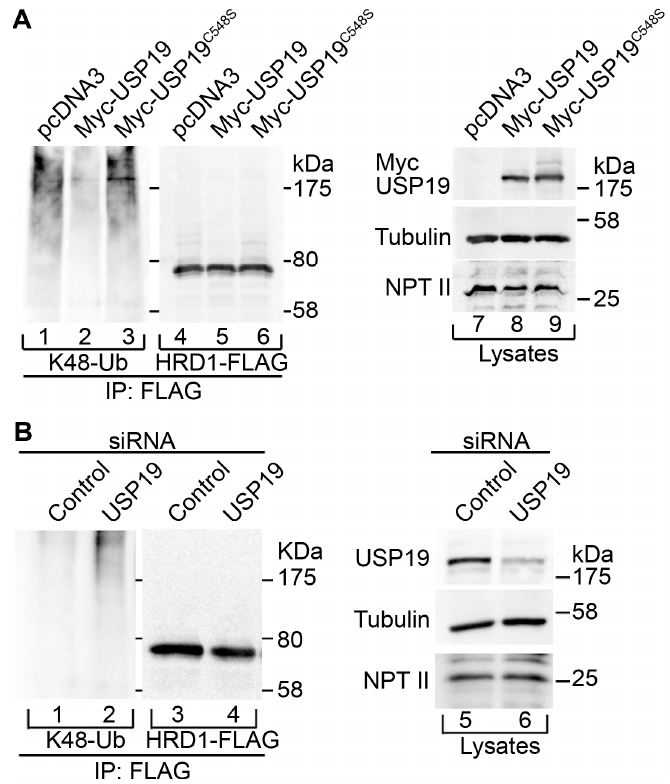
Figure 2. USP19 deubiquitinates HRD1. ( A ) HRD1-FLAG was transfected into 293T cells along with either pcDNA3 (lanes 1, 4 and 7), Myc-USP19 (lanes 2, 5 and 8) or Myc-USP19 C548S (lanes 3, 6 and 9). After epoxomicin treatment for 7.5 h, the cells were lysed and then subjected to immunoprecipitation (IP) with an anti-FLAG antibody under denaturing conditions. The immunoprecipitates (50% of the eluates) were analyzed by Western blotting with antibodies against K48-linked ubiquitin (lanes 1–3) and FLAG (lanes 4–6). The lysates (50 μ g of protein; lanes 7–9) were analyzed by Western blotting with antibodies against Myc ( top panel), α -tubulin ( middle panel) and NPT II (the Neo r gene product as a transfection control; bottom panel); ( B ) 293T cells were transfected with control siRNA (lanes 1, 3 and 5) or USP19 -specific siRNA duplexes (lanes 2, 4 and 6). Two days after transfection, the cells were further transfected with HRD1-FLAG. After epoxomicin treatment for 6 h, the cells were lysed and then subjected to immunoprecipitation (IP) with an anti-FLAG antibody under denaturing conditions. The immunoprecipitates (50% of the eluates) were analyzed by Western blotting with antibodies against K48-linked ubiquitin (lanes 1 and 2) and FLAG (lanes 3 and 4). The lysates (50 μ g of protein; lanes 5 and 6) were analyzed by Western blotting with antibodies against USP19 ( top panel), α -tubulin ( middle panel) and NPT II ( bottom panel).